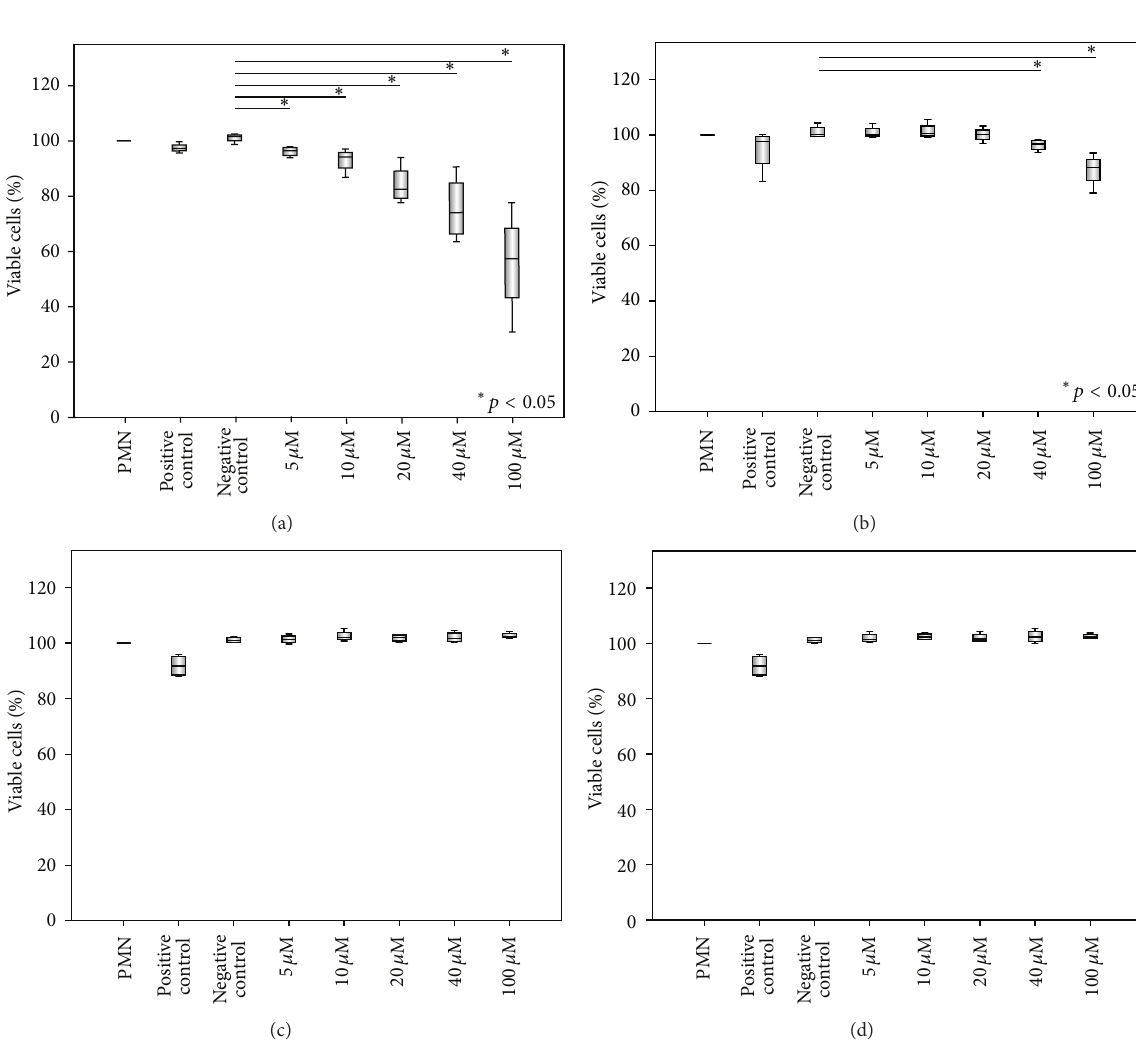
Figure 3: Neutrophil viability in response to CAAP48, CAAP47, scrambled peptide, and VIRIP. After 30min peptide incubation, PMN (1 × 10 6 cells/mL)weredoublestainedwithAnnexinV-FITCandpropidiumiodide(PI)for15minandanalyzedbyflowcytometry.Thepercentage of viable cells (PI and Annexin negative) is illustrated for different peptide concentrations. CAAP48 (a) leads to a marked reduction of the viability of neutrophils already at 5 𝜇 M (24 ng/ 𝜇 L) while CAAP47 (b) influences viability of PMN not before 40 𝜇 M (192 ng/ 𝜇 L). Both the scrambled peptide (c) and VIRIP (d) had no effect. Data of four independent experiments are shown. PMA was used as positive control